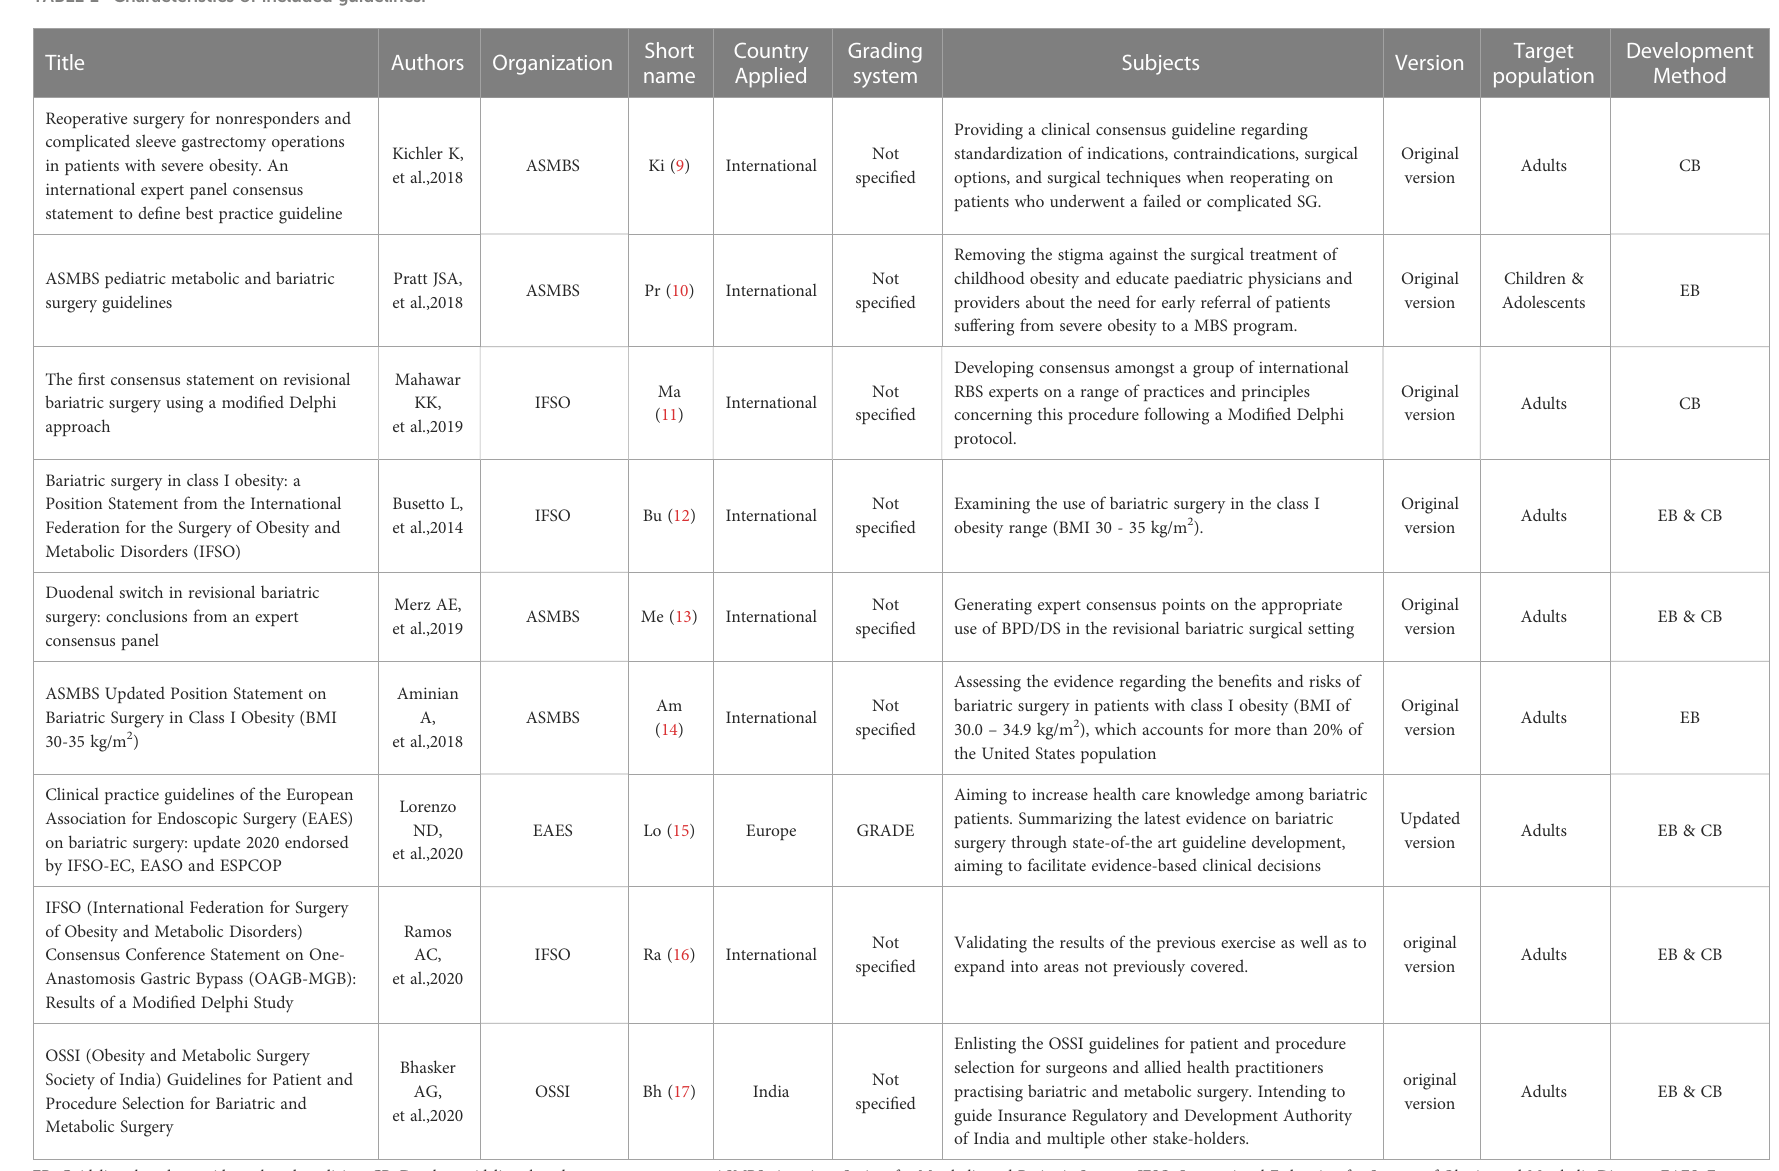
TABLE 1 Characteristics of included